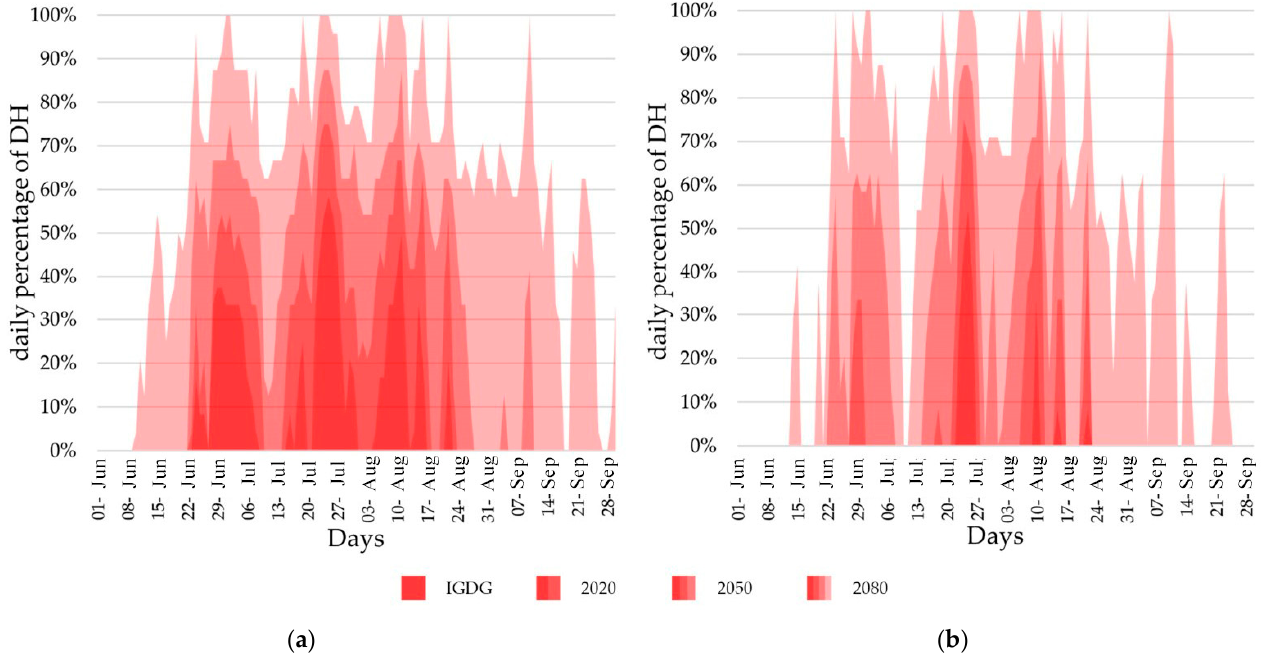
Figure 12. Percentage of daily discomfort hours: ( a ) room LM1, ( b ) room LS1. Similar patterns can be recognised referring to the single-occupancy